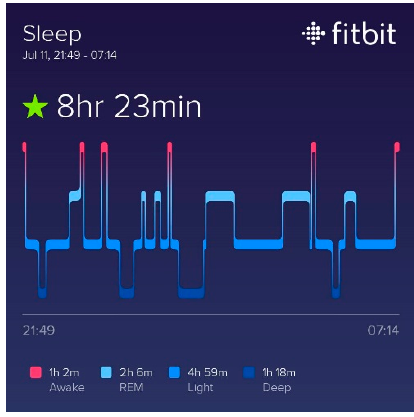
Figure A21. MUSCAT,